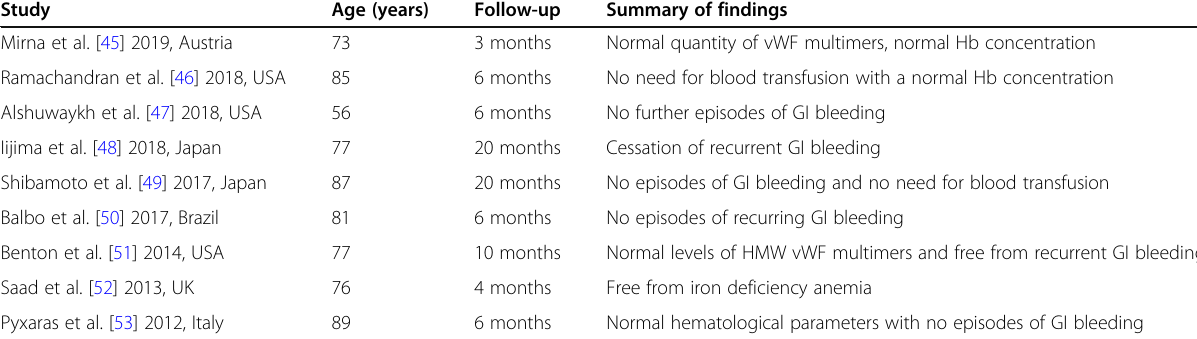
Table 2 Studies assessing the effectiveness of AVR in patients with Heyde ’ s